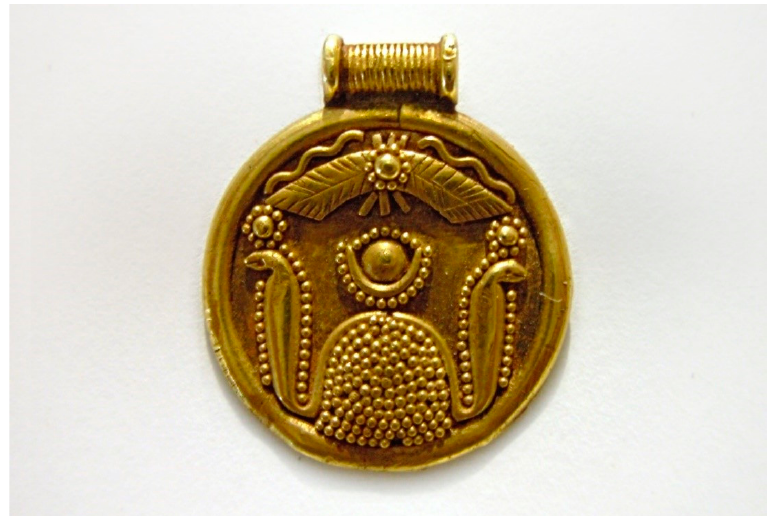
Figure 25. Egyptianizing scene with two cobras ( uraei ) (MGW inv. no. 1870); gold pendant; ca. 4th century BCE .